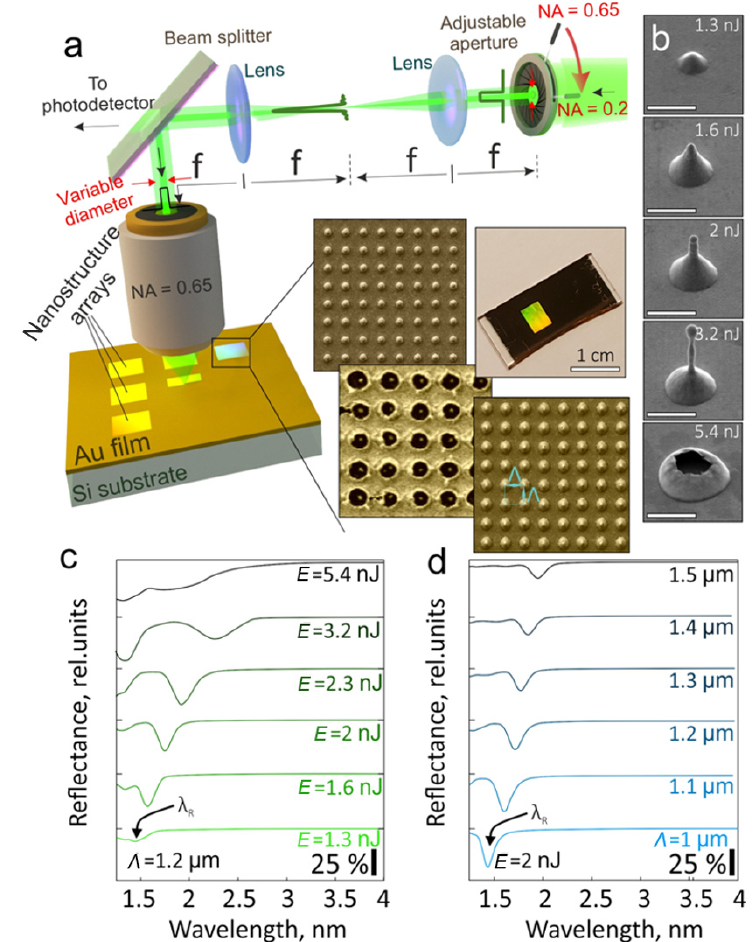
Figure 1. ( a ) Schematically illustrated setup for direct laser fabrication of nanostructure arrays using adjustable aperture to control the effective NA of the focusing objective. Insets show SEM images of typical nanostructure arrays with square arrangement and a periodicity Λ as well as optical photograph of the large-scale nanobump array. ( b ) Series of side-view SEM images of the isolated nanostructures produced at NA = 0.65 and applied pulse energy E ranging from 1.3 to 5.4 nJ. ( c , d ) FTIR reflectance spectra of the nanostructure arrays produced at variable pulse energy E and fixed array period Λ = 1.2 µ m ( c ) and variable Λ and fixed E = 2 nJ ( d